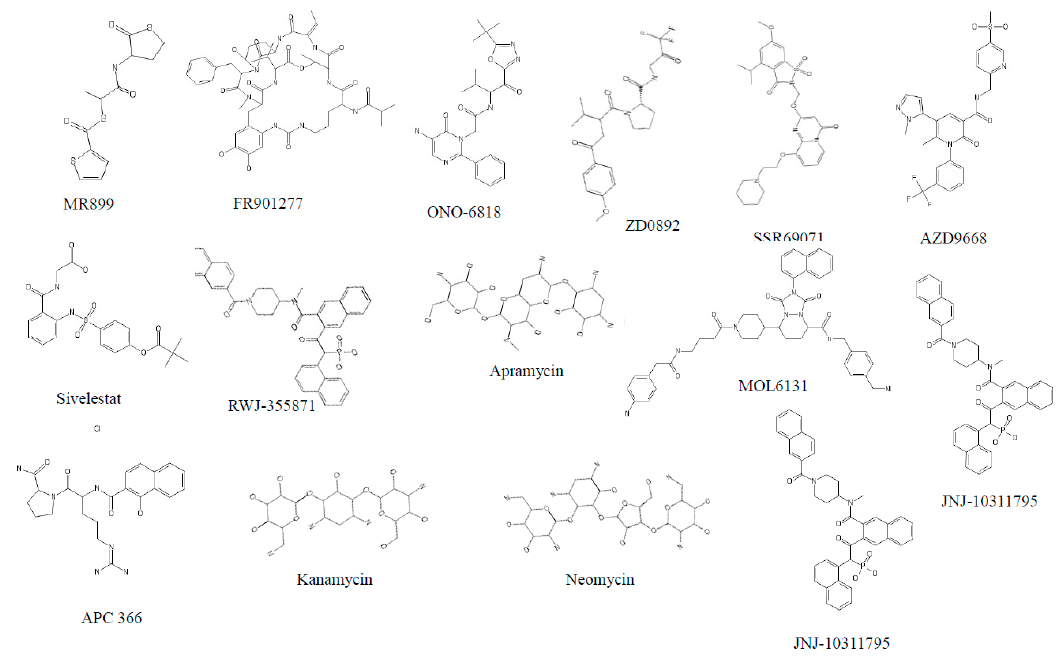
Figure 2. Structure of different serine protease inhibitors tested against COPD models.